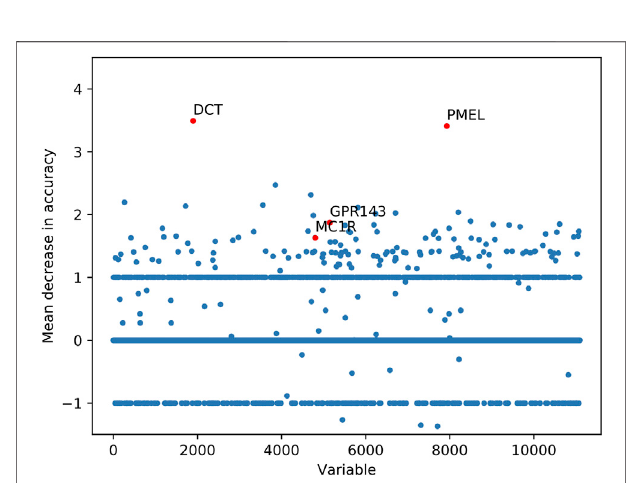
Frontiers in Pharmacology |